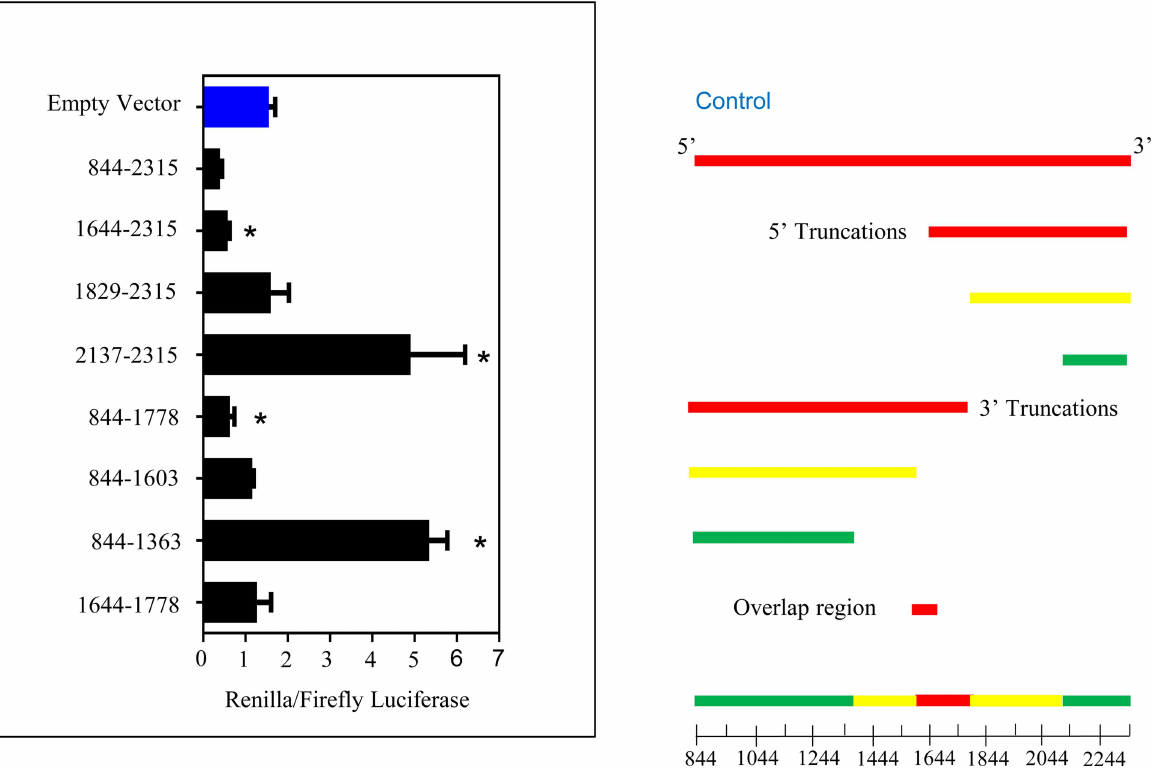
Fig 3. Translational regulation by HBEGF 3’UTR. Dual luciferase assays used constructs containingthe indicated sequencesof the HBEGF mRNA inserted 3’ to Renilla luciferase. The left panel shows activities of the Renillaluciferasenormalizedto a constitutive firefly luciferase. N = 3. * , p < 0.05 vs empty vector control (blue bar), ANOVA with Dunnett t-test. Right panel shows the locationsof the inserts in colors indicatingtheir effect on translation; yellow, neutral; red, suppression; green, activation. A scale in base pairs is shown